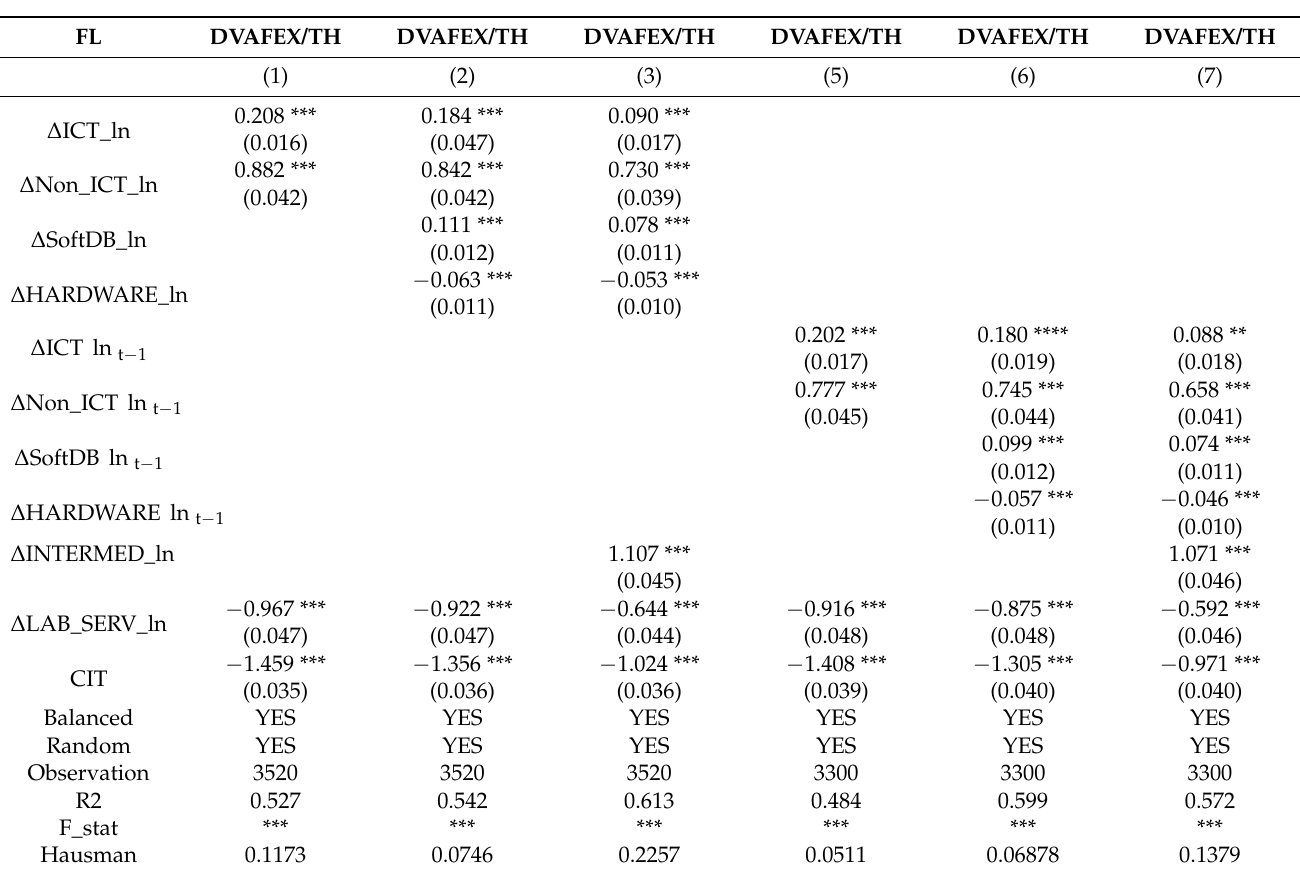
Table 4. Random effect panel regression results of the impact of ICT assets on forward linkages global value chains participation. The level of statistical significance is indicated as follows with symbols